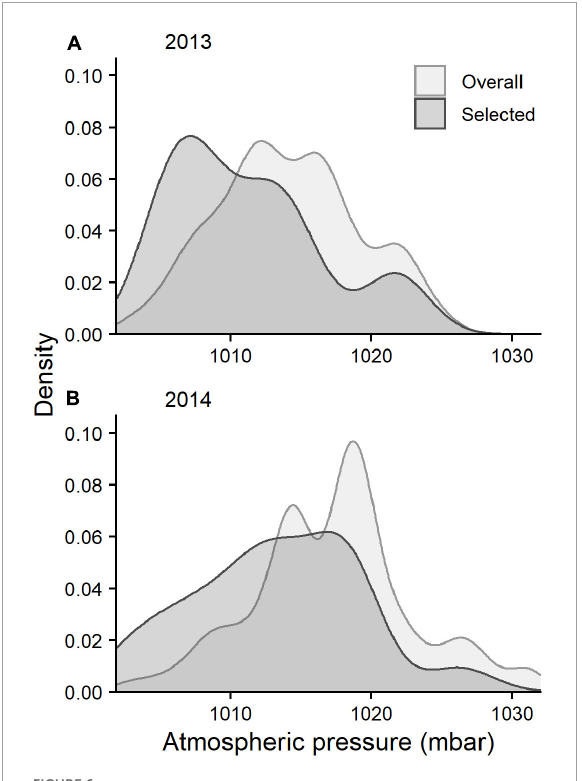
FIGURE6 Kernel density plots of atmospheric pressure throughout the Semipalmated Sandpiper departure period (August 22 to September 19) from the Bay of Fundy (“overall”) and during hours when birds departed (“selected”) in (A) 2013 and (B)